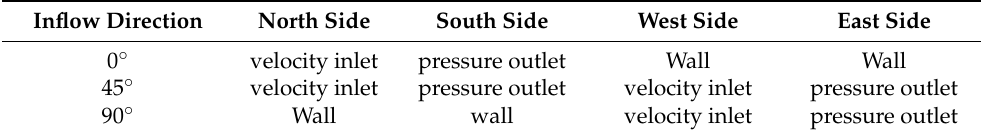
Table 1. Boundary conditions corresponding to airflow